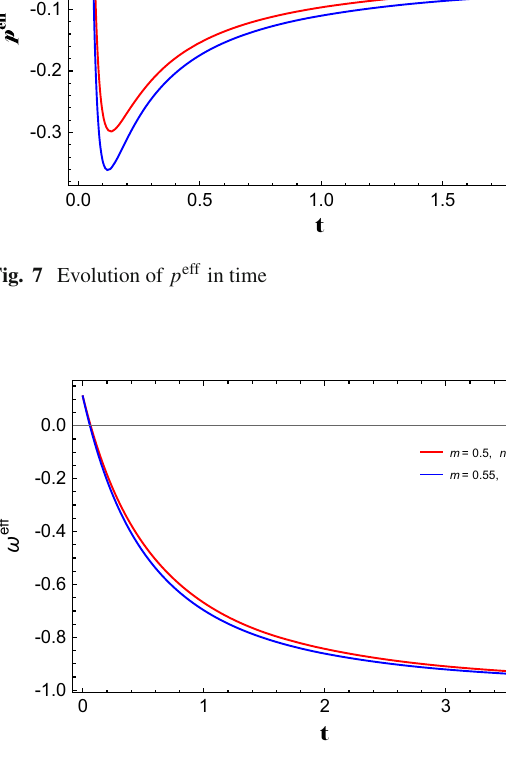
Fig. 8 Evolution of ω eff in